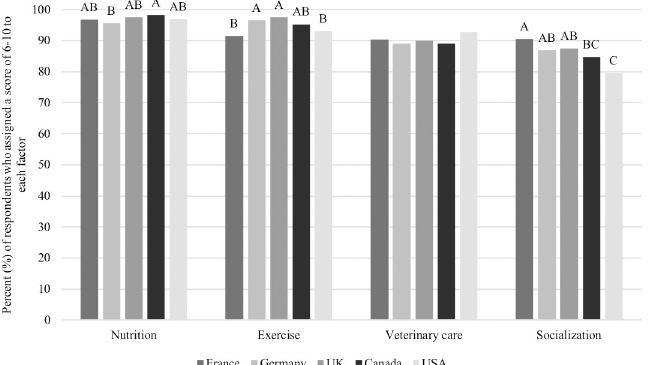
Fig 9. Percent of respondents who assigned a value of 6–10 to the factors important to dog ownership among countries (n = 3,298). Proportions in the same category that do not share a common letter are significantly different at P <